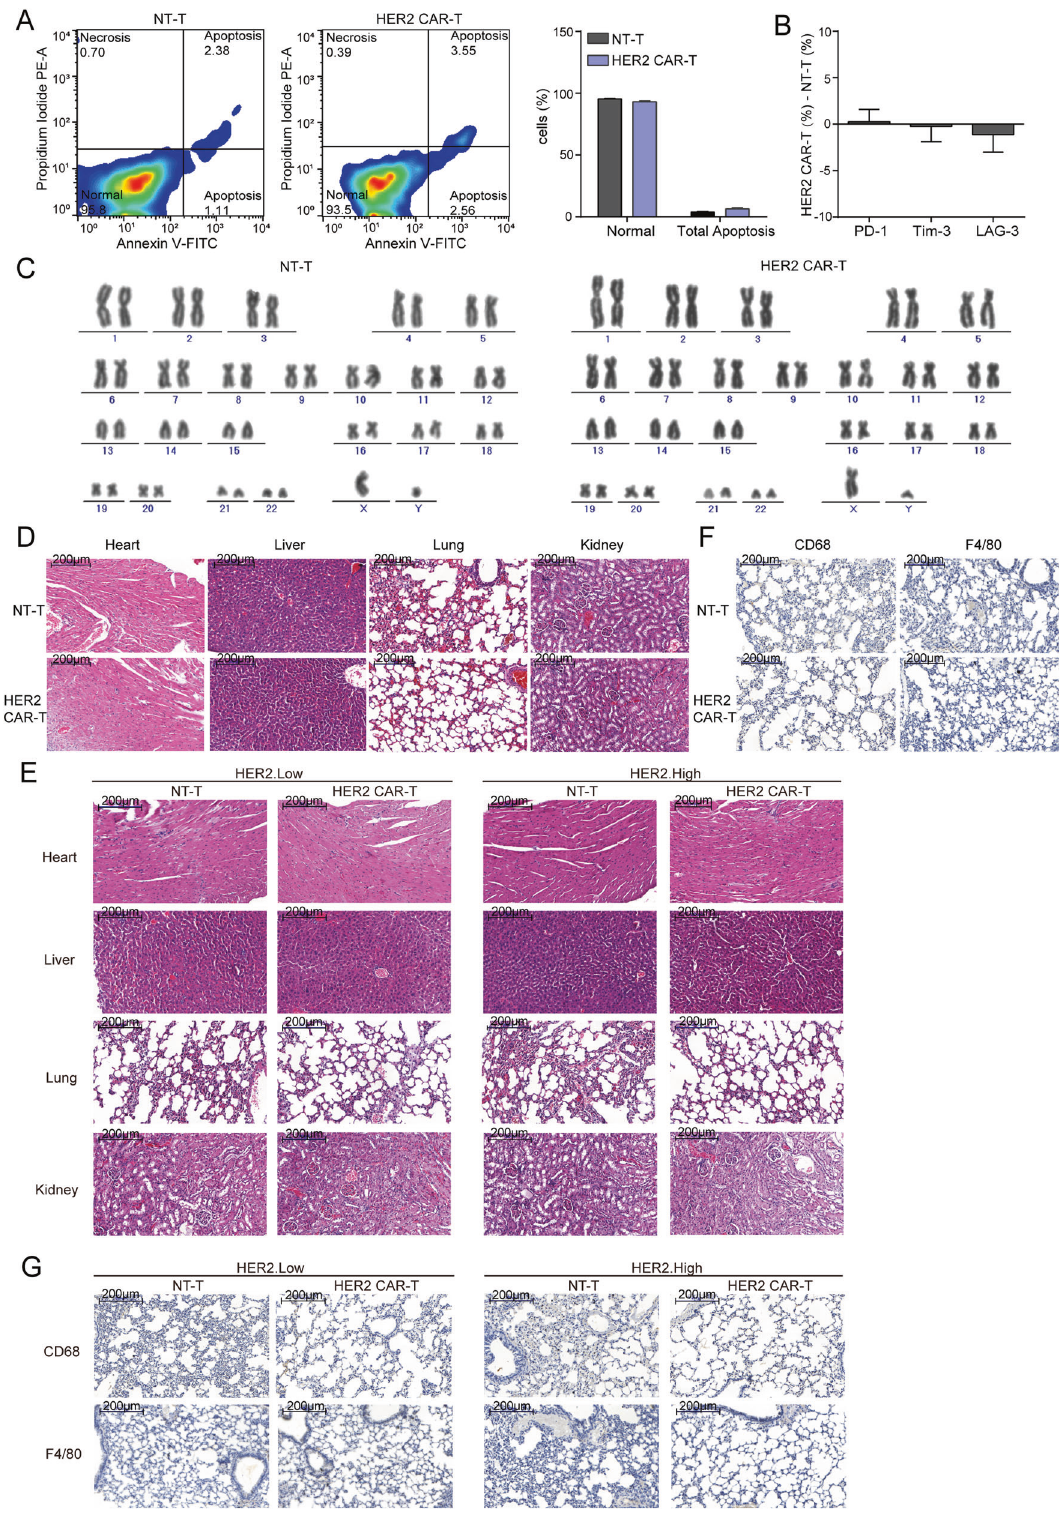
Fig. 7 Safety of HER2 CAR-T cells. A 7 days after lentivirus infection, an apoptosis detection kit was used to detect the apoptosis of T cells, and the representative images are shown. B The difference in the expression levels of three exhaustion markers between HER2 CAR-T and NT- T group (HER2 CAR-T (%) - NT-T (%)) as detected by fl ow cytometry on 7 days after lentivirus infection. C 14 days after lentivirus infection, karyotype analysis was performed to detect chromosomal alterations in CAR-T cells. D , E H&E was performed to evaluate the pathological changes in Heart, Liver, Lung, and Kidney, and the representative images are shown. The scale bar is marked in each image. F , G IHC assay was performed to observe F4/80 or CD 68 positive macrophages in murine lung tissues, and the representative images are shown. The scale bar is marked in each